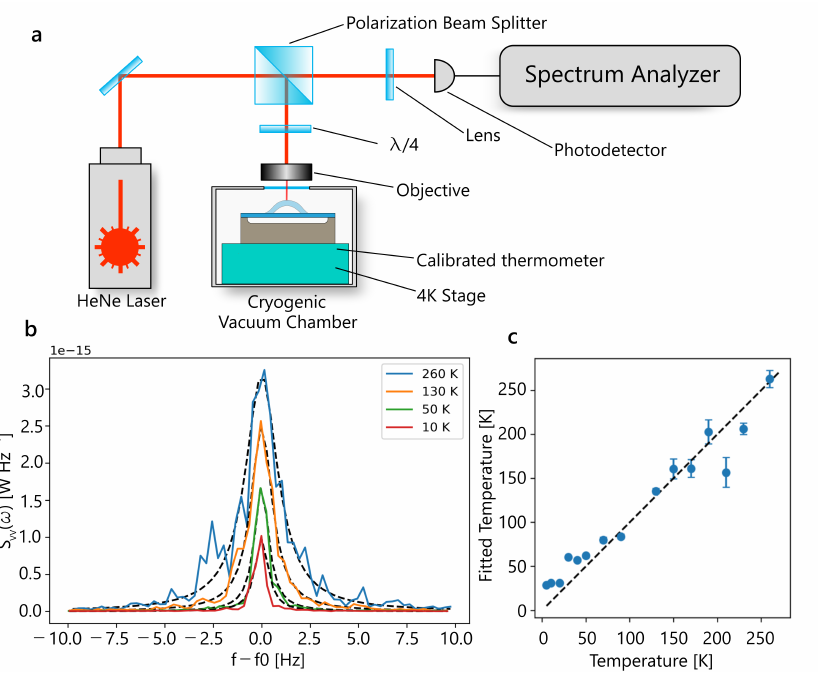
Figure 9. ( a ) Schematic of the mechanical characterization setup. The mechanical resonator is placed inside a cryogenic vacuum chamber and the displacement caused by Brownian motion. Interference between reflected laser light reflected from substrate and membrane causes a displacement dependent intensity on a photodiode that is detected using a spectrum analyzer; ( b ) thermomechanical noise spectra at different temperatures obtained using a spectrum analyzer. The x -axis is centered at the fundamental resonance frequency f 0 of each spectrum for comparison. Dashed lines represent fits using (5). ( c ) temperature extracted from the measurements in ( a ) by integrating the area under the peak. The error bars show the standard